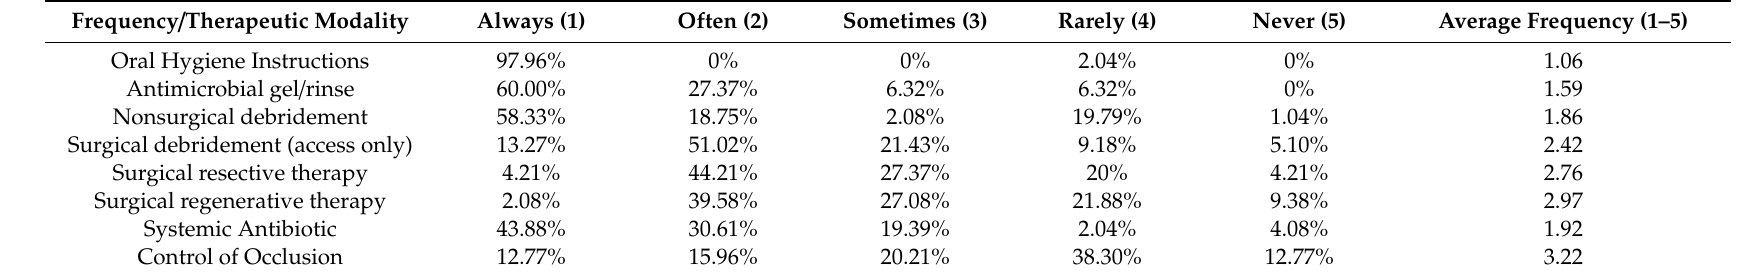
Table 5. Peri-implantitis Treatment Modalities: Average Frequency (Always (1) through to Never